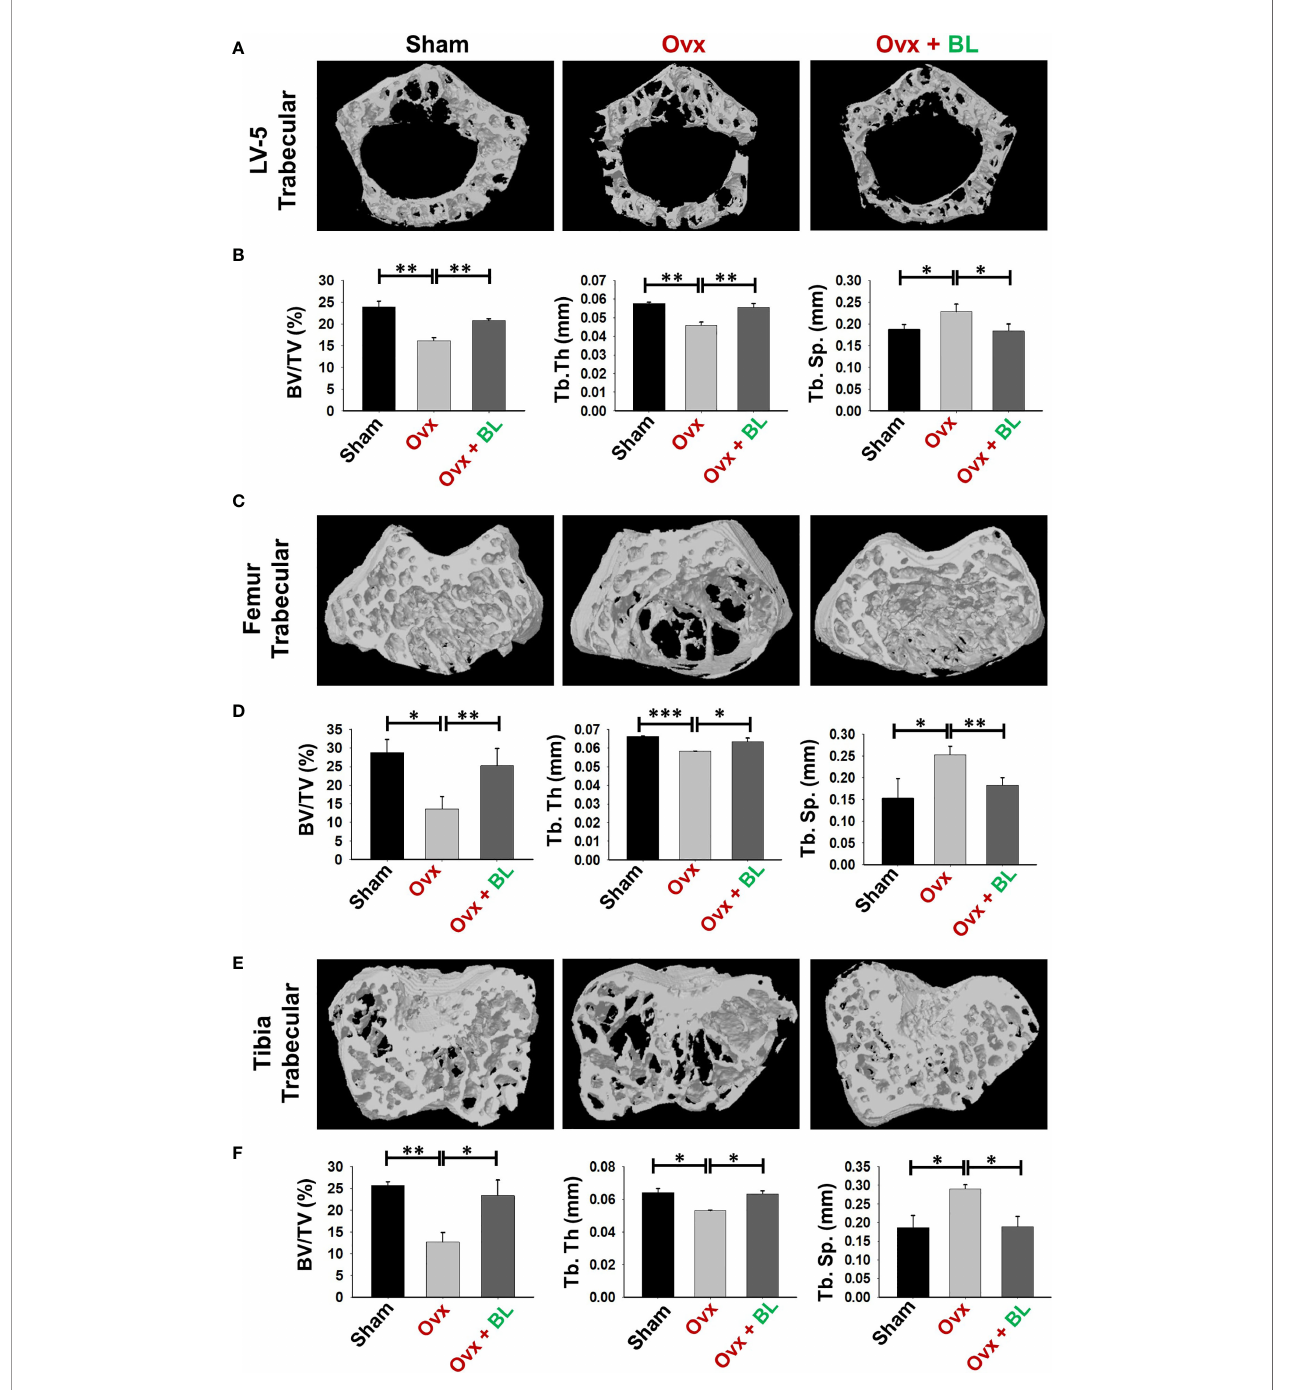
FIGURE 6 | BL administration improves trabecular bone microarchitecture. 3D uCT reconstruction of LV-5 trabecular, femur trabecular, and tibia trabecular of all groups. (A) Bone micro-architecture of LV-5 trabecular. (B) Histomorphometric parameters of LV-5 trabecular. (C) Bone micro-architecture of femur trabecular. (D) Histomorphometric parameters of femur trabecular. (E) Bone micro-architecture of tibia trabecular. (F) Histomorphometric parameters of tibia trabecular. Histomorphometric parameters: BV/TV, bone volume/tissue volume ratio; Tb. Th., trabecular thickness; Tb. Sp., trabecular separation. The results were evaluated by ANOVA with subsequent comparisons by Student ’ s t-test for paired or non-paired data. Values are reported as mean ± SEM. The above graphical representations are indicative of one independent experiment, and similar results were obtained in two different independent experiments with n = 6. Statistical signi fi cance was considered as p ≤ 0.05 with respect to indicated mouse